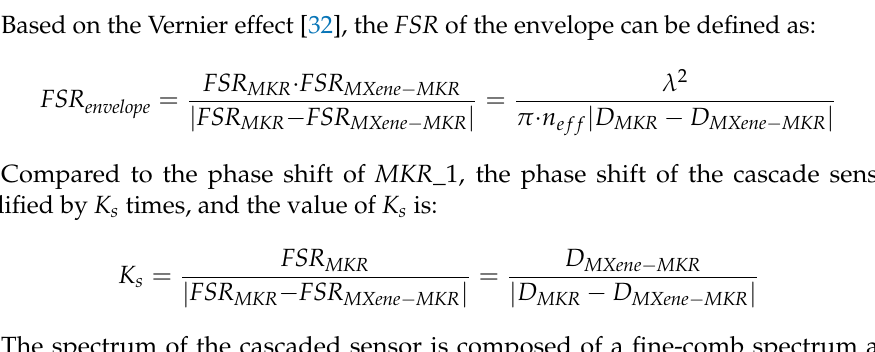
Figure 5. Transmission spectra of the ( a ) MKR; ( b ) MXene-MKR; ( c ) cascade system.